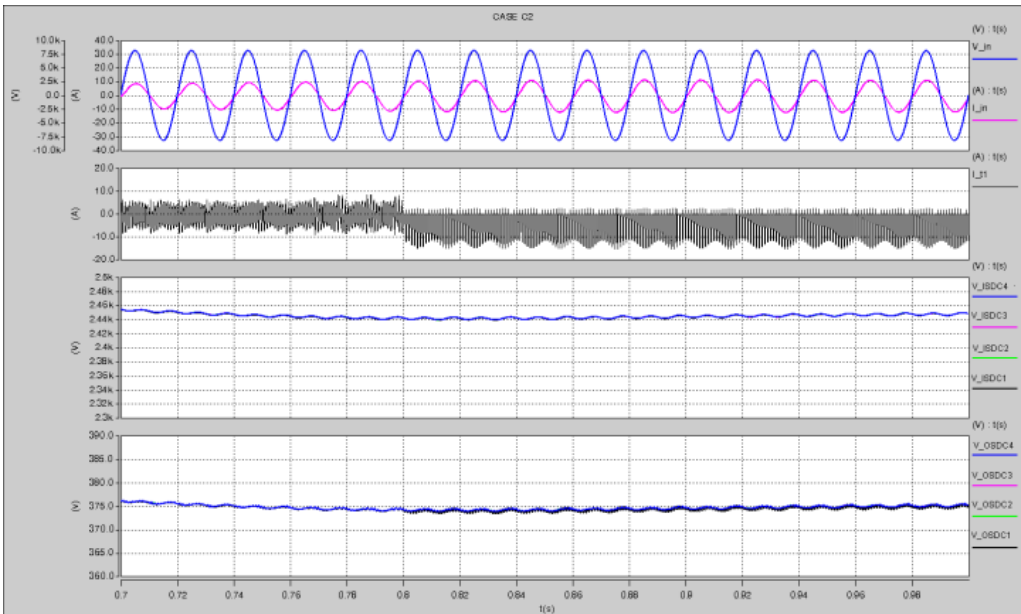
Figure 16. Simulation results of fault